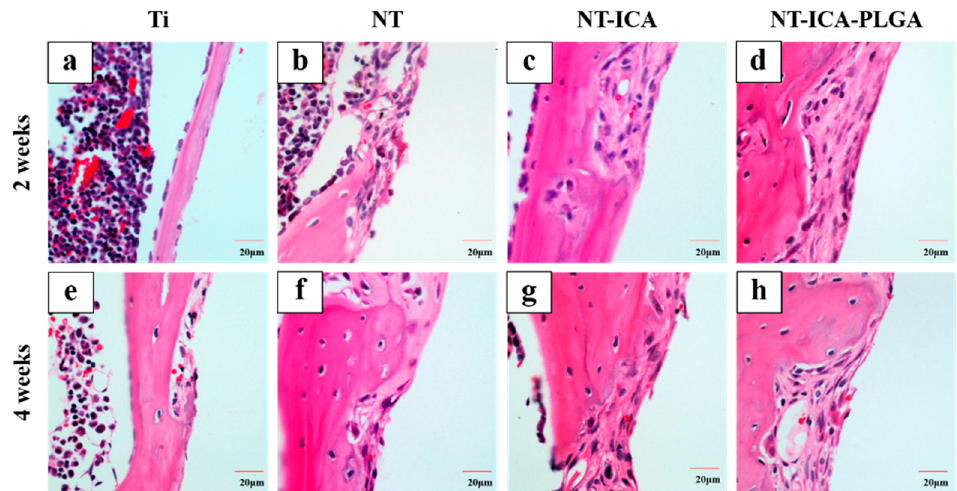
Figure 9. Histological analysis of the decalcification samples around different implants was evaluated by H&E staining. Scale bar, 20 μ m. Ti ( a,e ); NT ( b,f ), TiO 2 nanotubes; NT-ICA ( c,g ), TiO 2 nanotubes loading icariin; NT-ICA-PLGA ( d,h ), icariin-functionalized coating on TiO 2 nanotubes surface; ( a – d ) Two weeks after implantation; ( e – h ) Four weeks after implantation. Three fields of view were pictured at random for each section and three different sections from three different experimental replicates were observed for each group. The most representative images were displaced in each group.